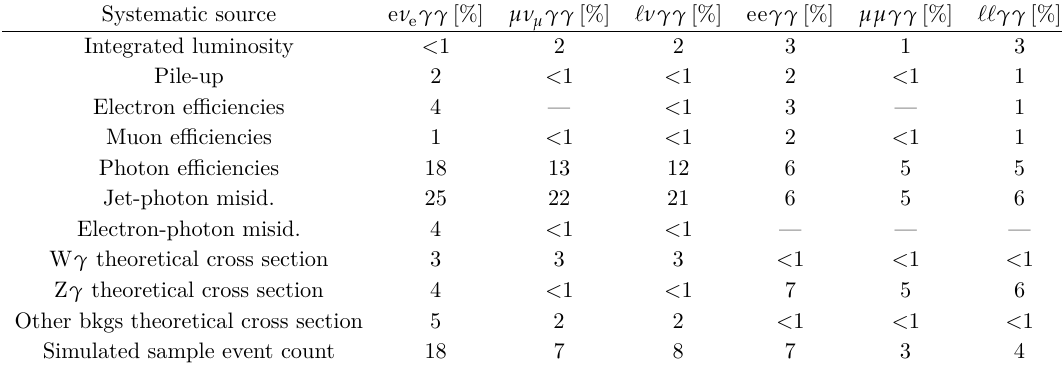
Table 1 . Summary of the systematic uncertainties (in percent) for the W gg and Z gg cross section measurements. The numbers indicate the impact of each systematic uncertainty in the value of the measured cross section in the corresponding channel. The systematic uncertainties in the jets misidentified as photons are added in quadrature in the